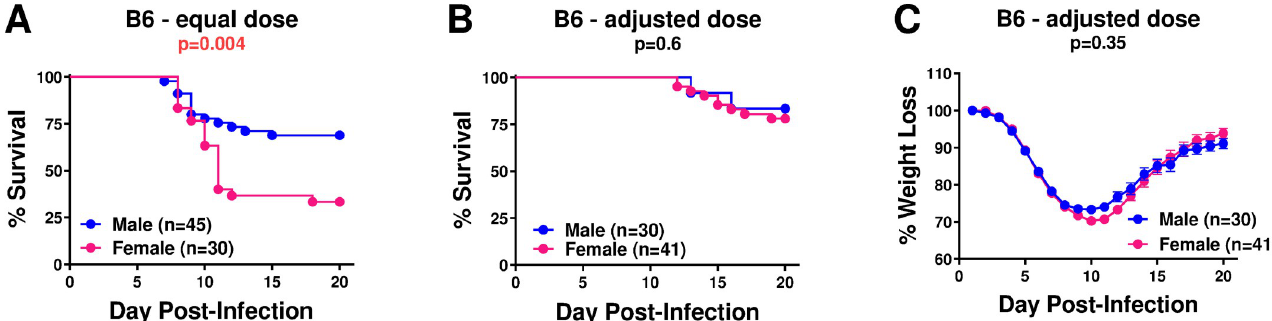
Fig 2. Sex differences and normalization of IAV severity in male and female B6 mice. ( A ) B6 male and female mice were challenged with equal doses of PR8 IAV, and survival was assessed. ( B and C ) B6 male and female mice were challenged with sex-adjusted estimated LD 50 of PR8 IAV (33% lower dose for females). Significance of differences in survival between females and males was determined using the Mantel-Cox test, significance of differences in weight loss was determined by two-way ANOVA (overall effect of sex). P values are indicated below each panel title. The number of animals per condition is indicated in each